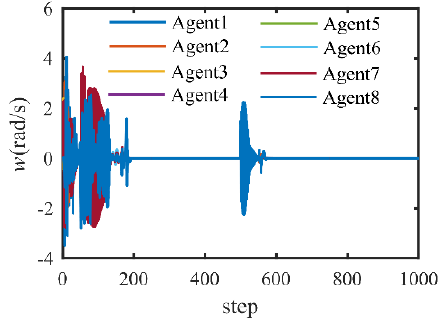
Figure 4. Velocity control result with linear controller.